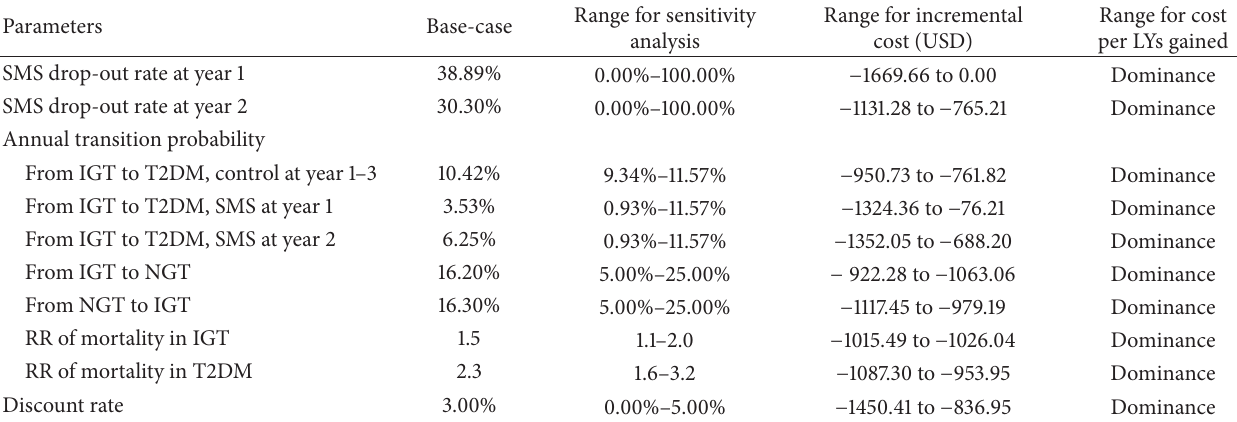
Table 4: Results of sensitivity analyses.